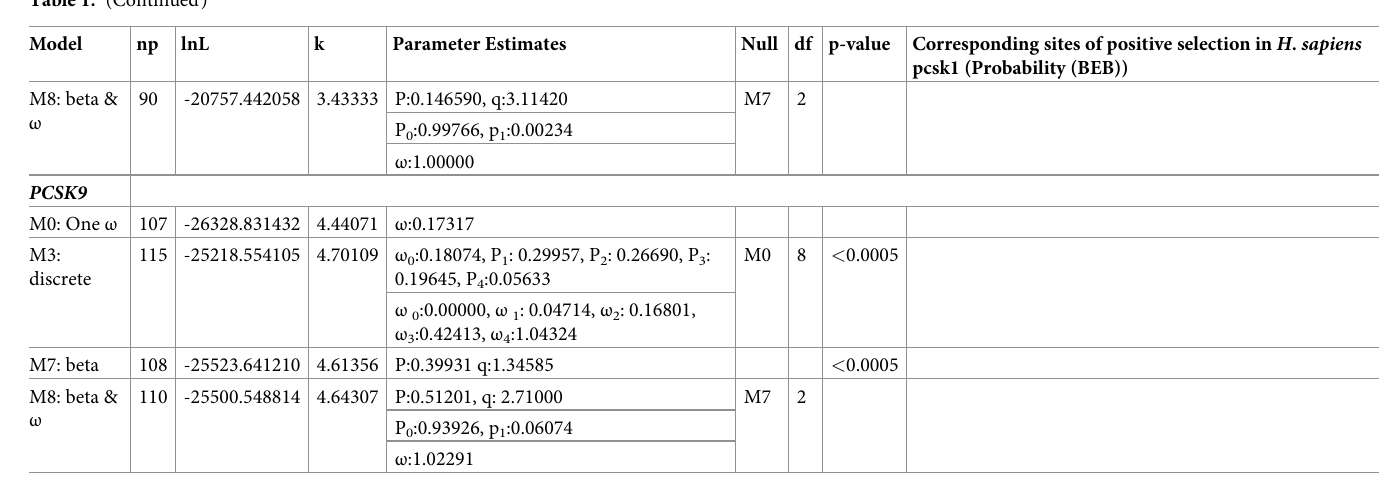
protein [11]. Glutamine at position 25 was not conserved among mammalian species of our study and only 10 species including Mus musculus (house mouse), Chrysochloris asiatica (cape golden mole), Eptesicus fuscus (big brown bat) and primate order, had glutamine at this posi- tion. The rest of the animals had arginine, histidine, and cysteine at this position. Amino acid proline at position 42 was changed to leucine in Neophocaena asiaeorientalis asiaeorientalis , Galeopterus variegatus (sunda flying lemur), Marmota flaviventris (yellow-bellied marmot), Cavia porcellus (guinea pig), Octodon degus (degu), Heterocephalus glaber [naked mole-rat], and Urocitellus parryii (arctic ground squirrel), glutamine in Elephantulus edwardii (cape ele- phant shrew) and Loxodonta africana (african bush elephant), and tryptophan in Peromyscus maniculatus bairdii [prairie deer mouse], while other animals have proline at position 42 (S27 File and Fig 7B).